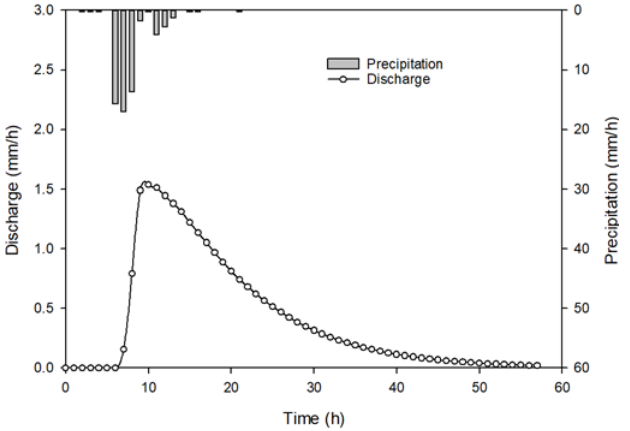
Figure 2. Typical hydrograph of a drainage ditch at the study site.